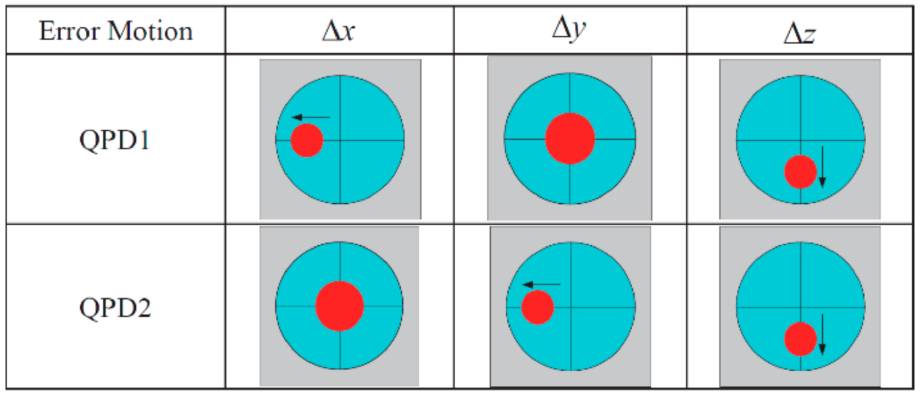
Figure 38. Relationship between laser spot deviation and spindle error motion